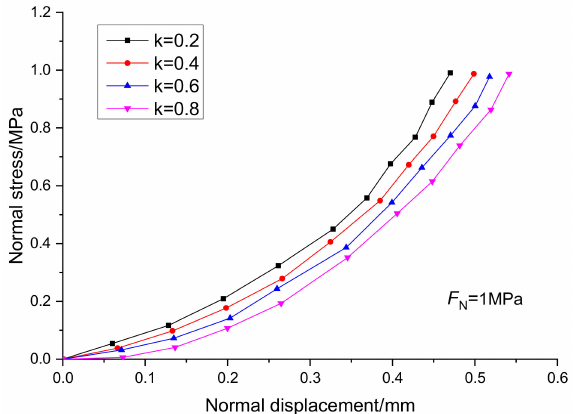
Figure 9. Relationship curves between normal displacement and normal stress at di ff erent continuity